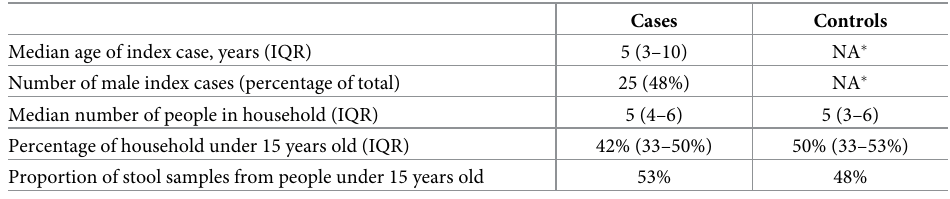
Table 1. Summarised demographic information about cases, and case and control households.